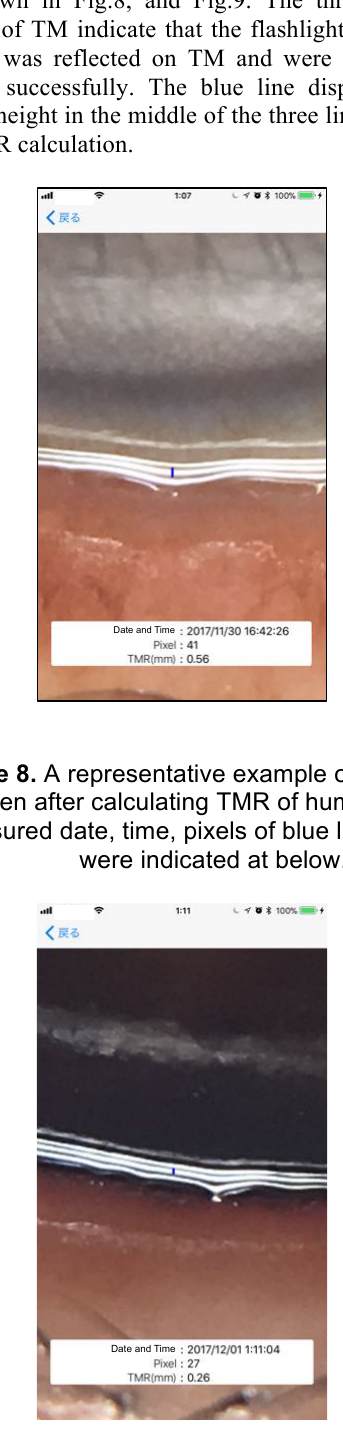
Figure 9. Another example of smartphone screen after calculating TMR of human subject. Measured date, time, pixels of blue line and TMR were indicated at